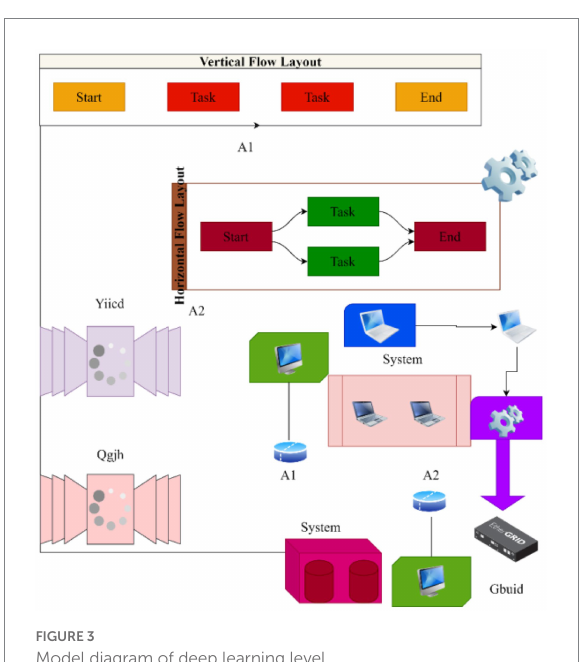
FIGURE 3 Model diagram of deep learning